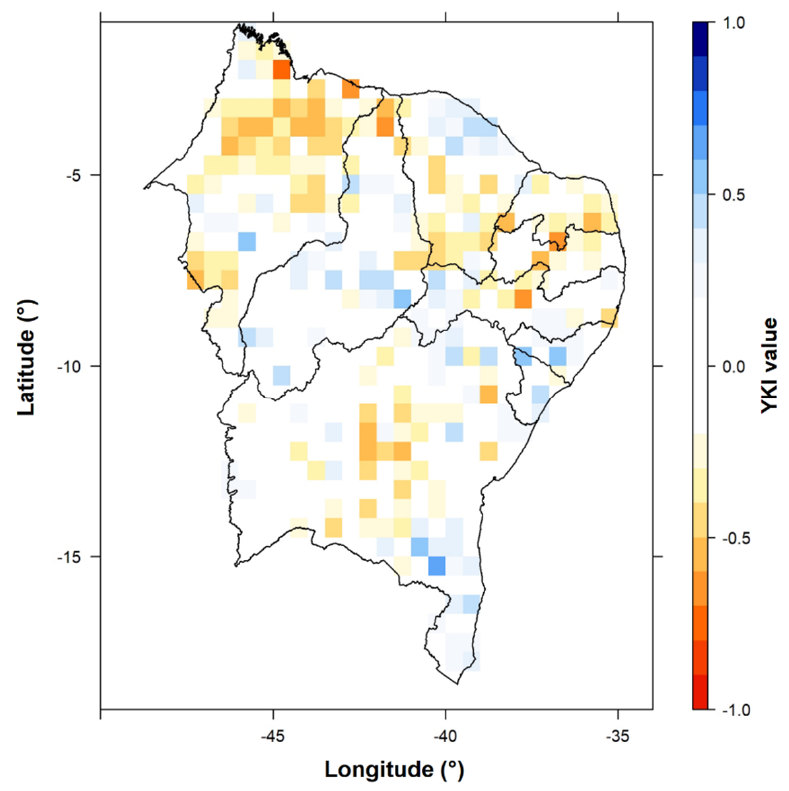
Figure 4. Yule–Kendall skewness statistics for precipitation anomaly data of the FMA quarter (1982– 2010).